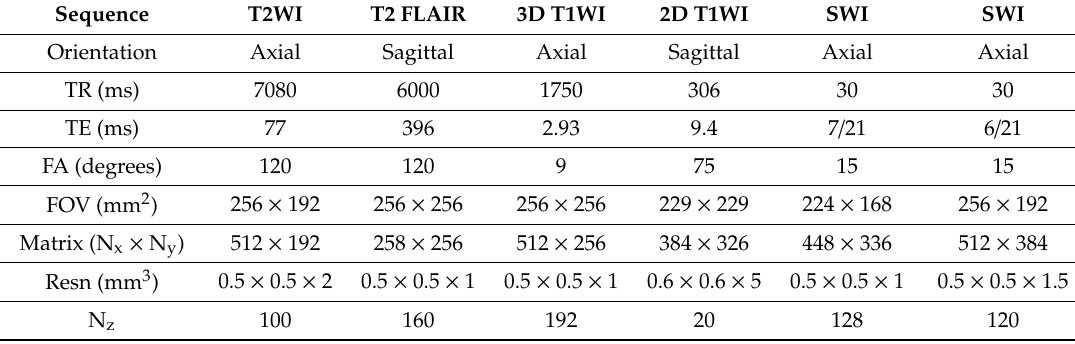
Table 1. Imaging parameters for the sequences used for cohort